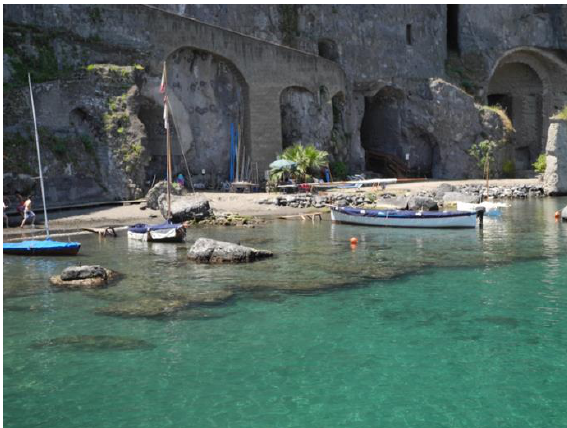
Figure 2. Access to the sea, underwater piers and ninfeo